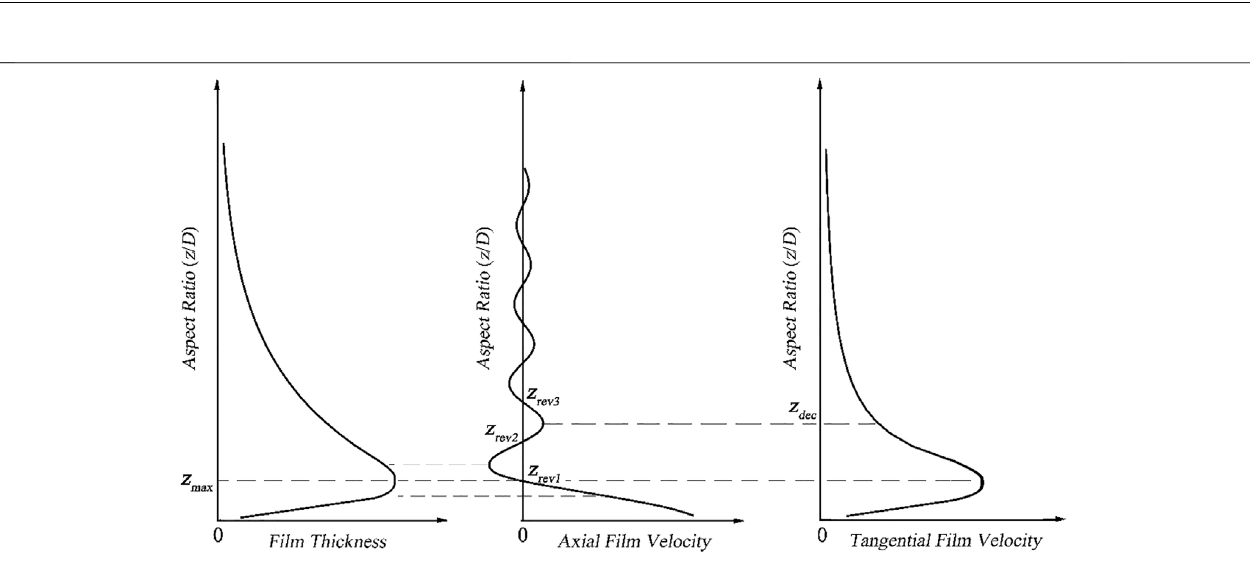
FIGURE 13 | Typical distribution of USLF thickness, axial fi lm velocity, and tangential fi lm velocity.